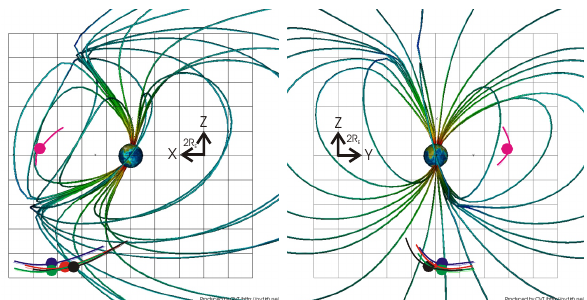
Figure 1 Fig. 1. Orbits of the Cluster (black, red, green, and blue) and Po- lar (magenta) satellites for 06:00–11:00 UT on 2 February 2003 in the GSM X − Z (left panel) and Y − Z planes. The background magnetospheric field lines are from the Tsyganenko-96 model with B z =− 7nT, P dyn = 5nPa, and D st = − 40, as appropriate for the event. The figure was produced using the Orbit Visualization Tool by Stasiewicz et al.